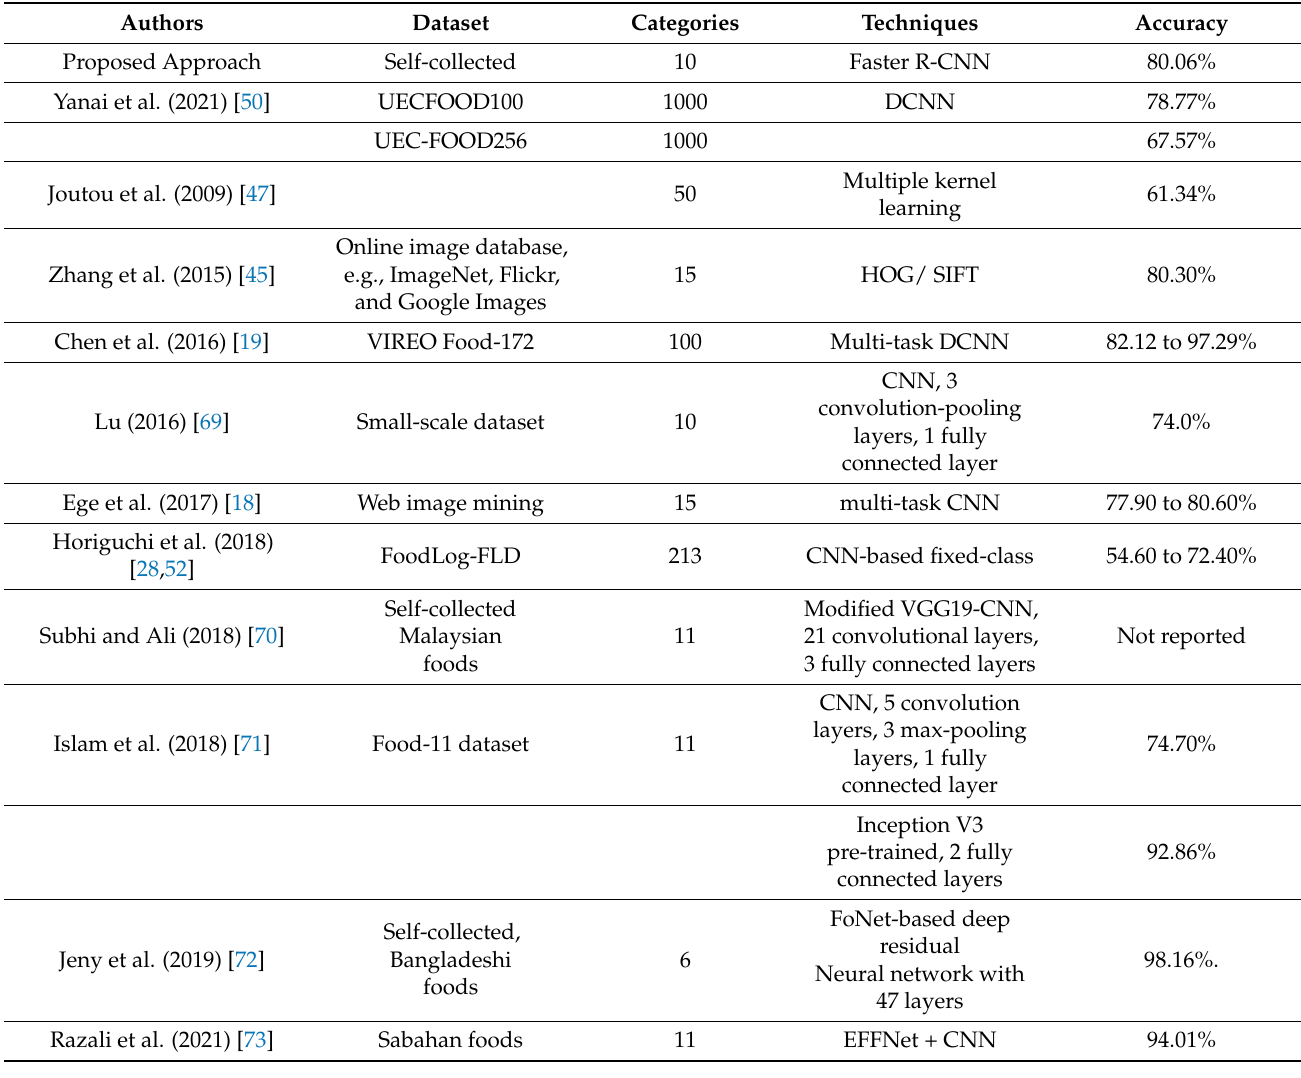
Table 3. Results from the real environment